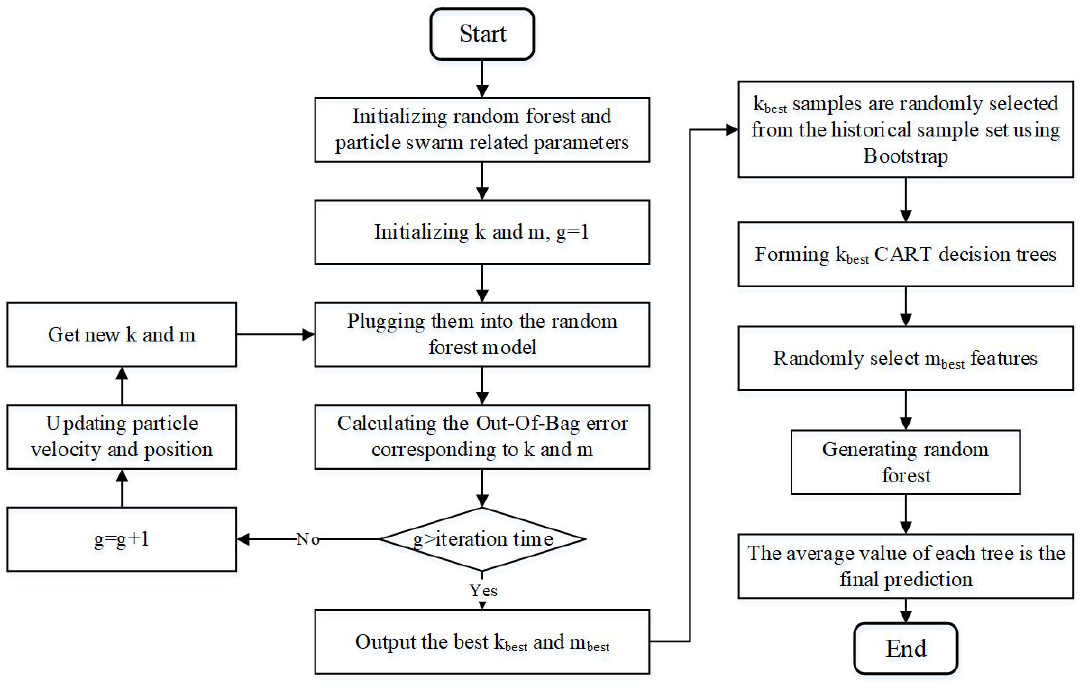
Fig. 1. The structure of new RF.